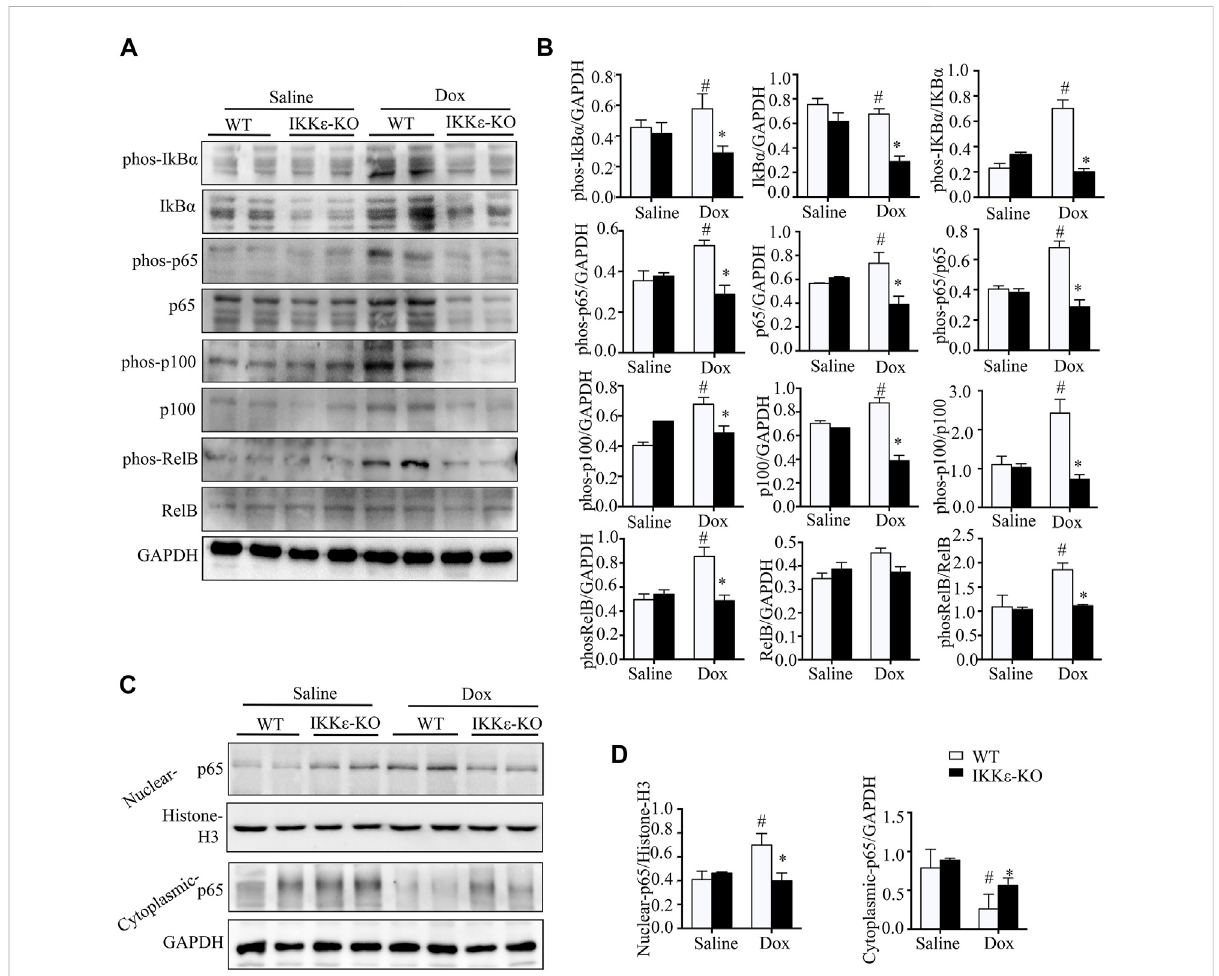
FIGURE 5 IKK ε knockout inhibited the NF- κ B signaling pathway in Dox-induced DCM. (A) . Representative western blots showing total protein and the phosphorylation levels of I κ B α , RelB, p65, and p100 in the NF- κ B pathway in heart tissues of WT and IKK ε -KO mice injected with Dox ( n = 6 mice per experiments). (B) . Quantitative analysis of western blotting of proteins related to the NF- κ B pathway ( n = 6 mice per experimental group; # p /* p < 0.05vs.SalineorWTDOX). (C) .Representativewesternblotsshowingthenuclearandcytoplasmicproteinlevelsofp65intheNF- κ